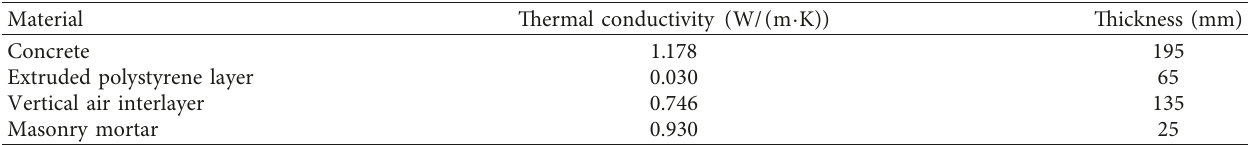
Table 7: Thermophysical parameters of materials in